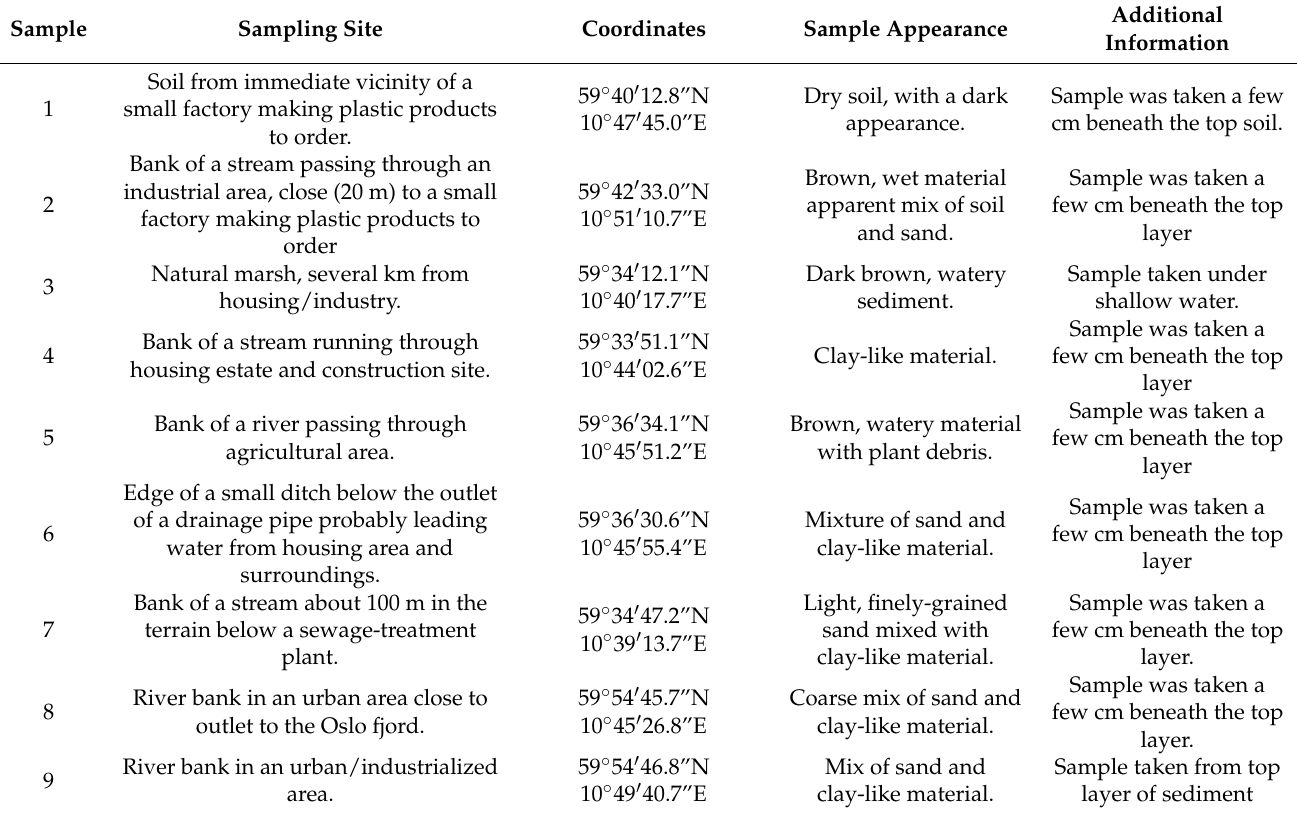
Table 1. Details on the nine sampling sites forming the core of the